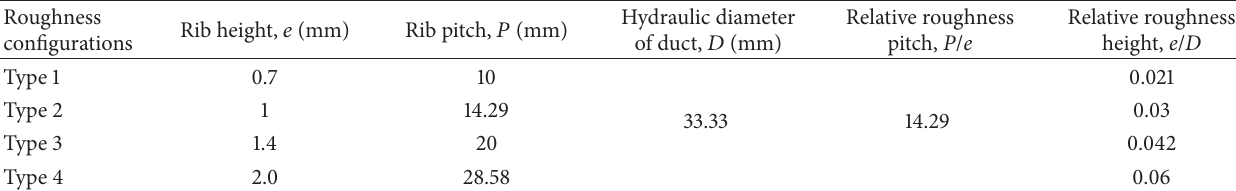
Table 1: Configurations of artificial roughness used in the study.